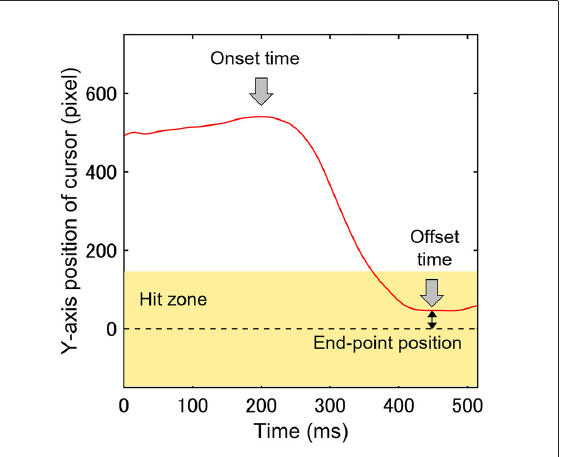
FIGURE5 A single trajectory of cursor movement along the Y-axis was used to analyze three parameters (RCA onset time, offset time, and end-point position). The light yellow band indicates the Hit zone, and the zero value of the Y-axis is the center of the